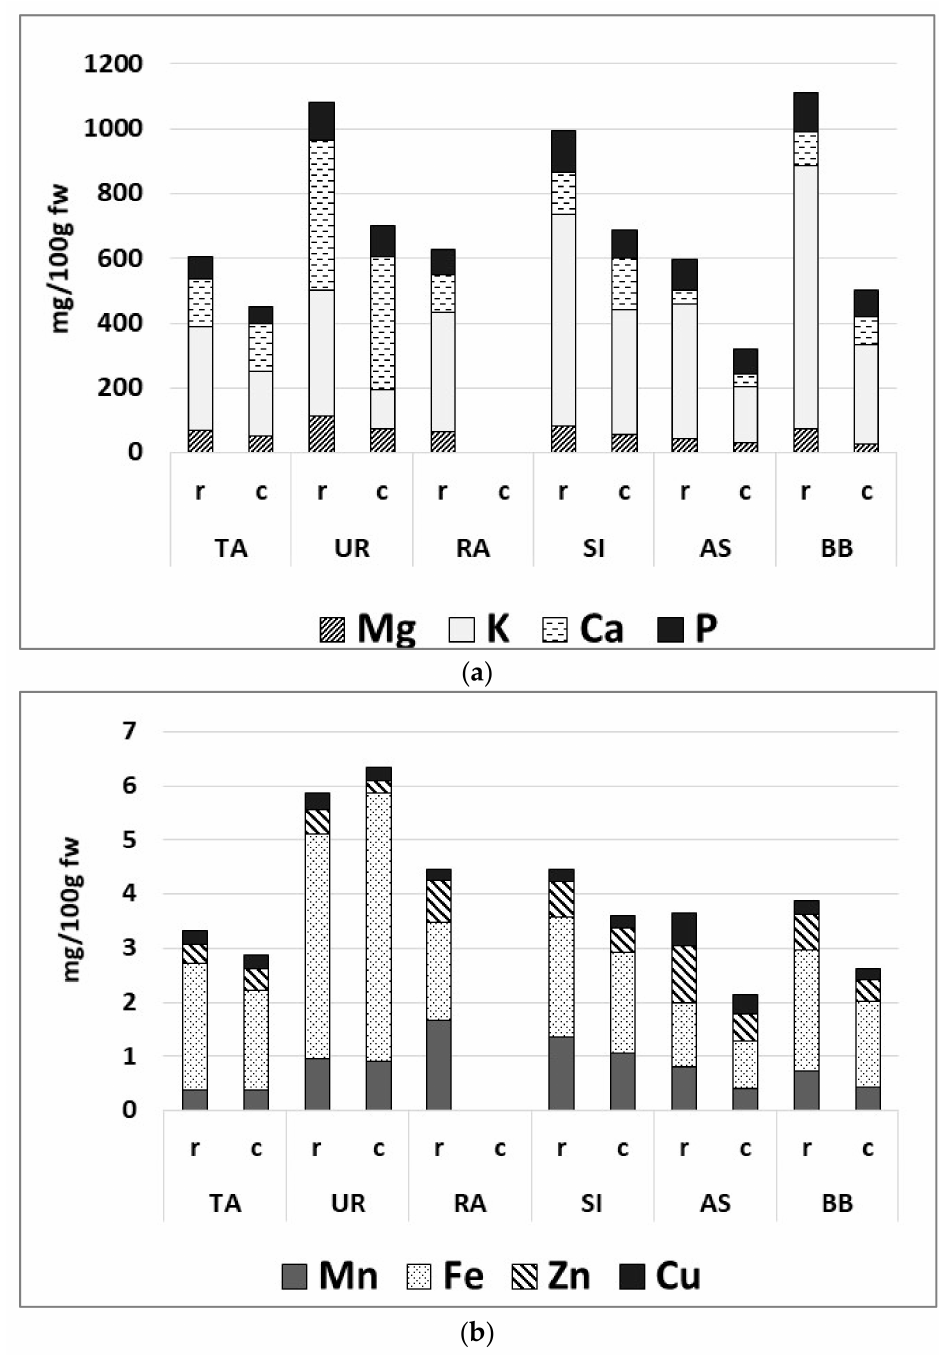
Figure 2. Contents of macro- ( a ) and micro- ( b ) elements in raw and cooked plants (mg/100 g FW). T. officinale (TA), U. dioica (UR), R. acetosa (RA), S. vulgaris (SI), A. dioicus (AS), B. bonus-henricus (BB). r, raw sample and c, cooked